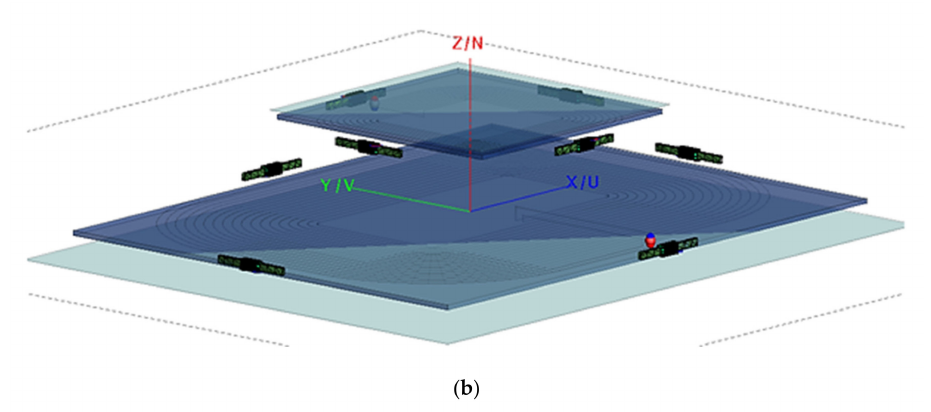
Figure 6. Ferrite antenna mounted on WPT system for EV. ( a ) Mounted on each corner; ( b ) mounted on the center of each side.